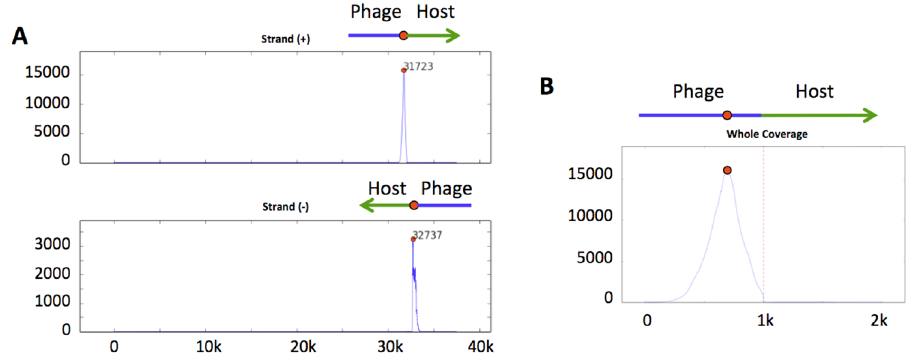
Figure 3. Detection of Mu-like phages. Hybrid fragments with one read on the phage genome and one read on the host genome are detected. ( A ) The sequence coverage of reads belonging to hybrid fragments of phage Mu is plotted along the phage genome. ( B ) Zoom in around the right terminus of phage Mu. The dotted red line represents the terminus